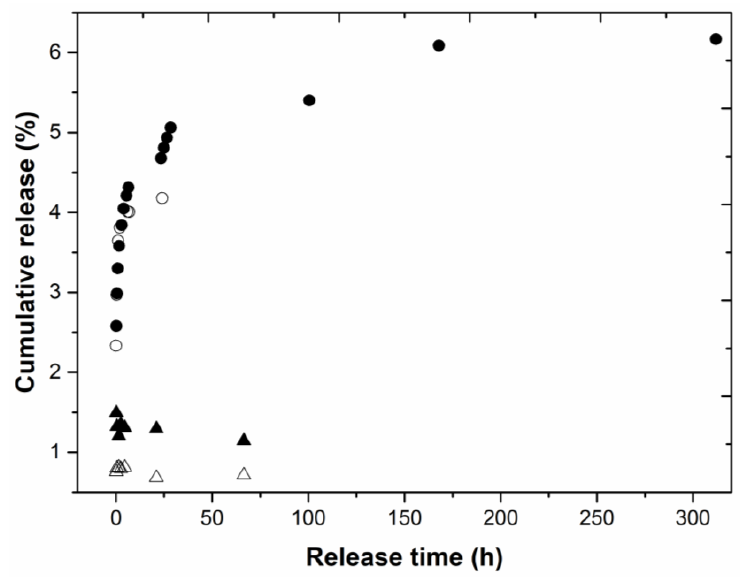
Figure 8. Cumulative release of rosmarinic acid (open circles, adsorbed on HAp; solid circles, incor- porated in situ) and chlorogenic acid (open triangles, adsorbed on HAp; solid triangles, incorporated in situ at 0.05 mM polyphenol initial concentration).